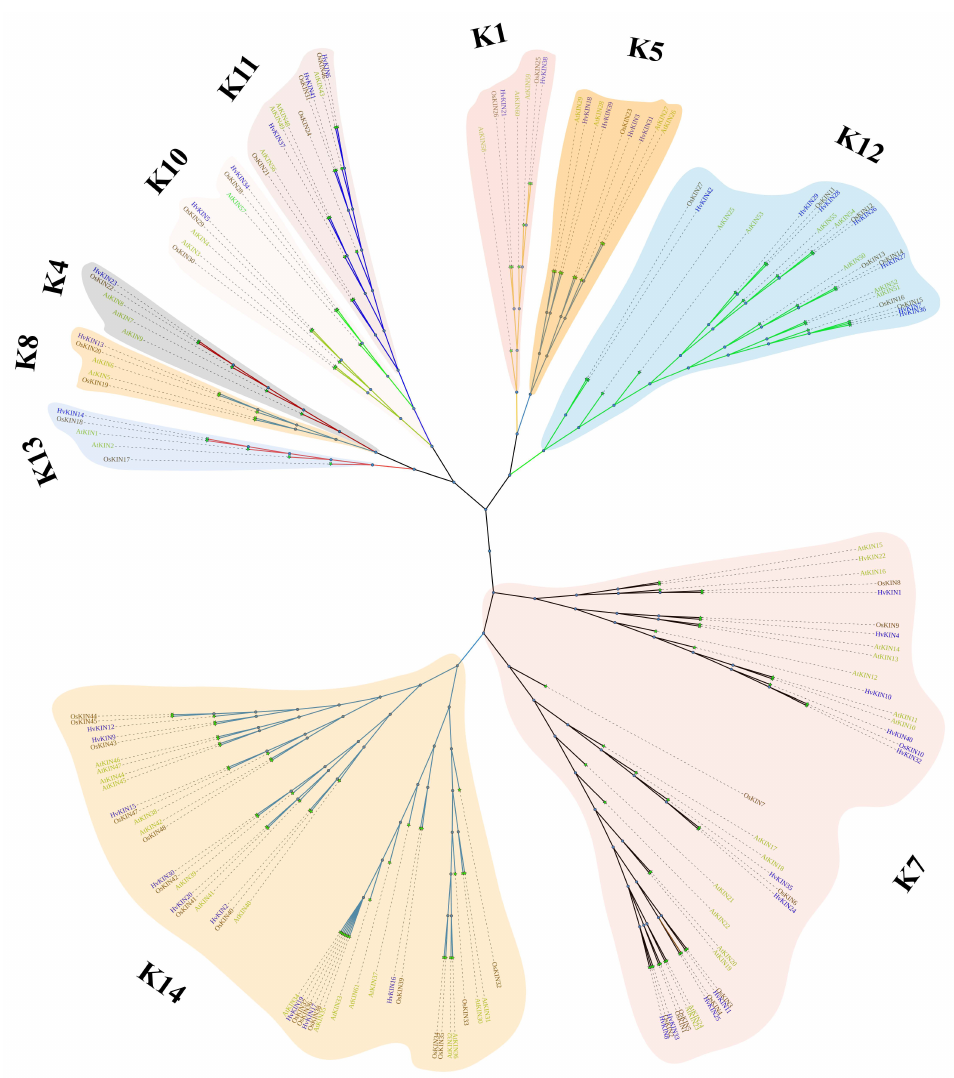
Figure 3. Phylogenetic analyses of KIN protein. Using MEGA7.0 software (Temple University, Philadelphia, Pennsylvania, USA.) to generate the KINs’ phylogenetic tree with the default settings. K1, K4, K5, K7, K8, K10, K11, K12, K13 and, K14 are 10 subfamilies of kinesins. Different colors